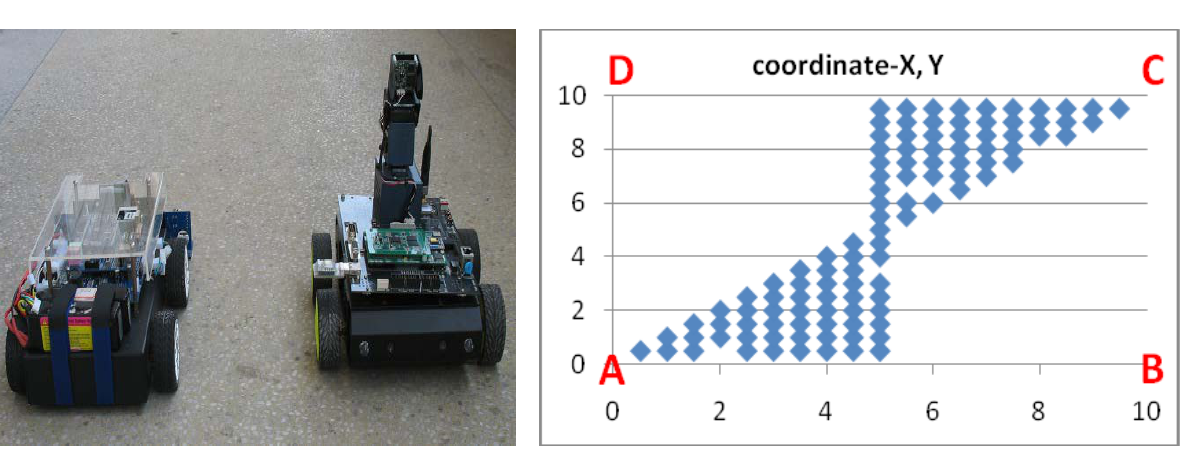
Figure 2. 104 experimental hopscotch